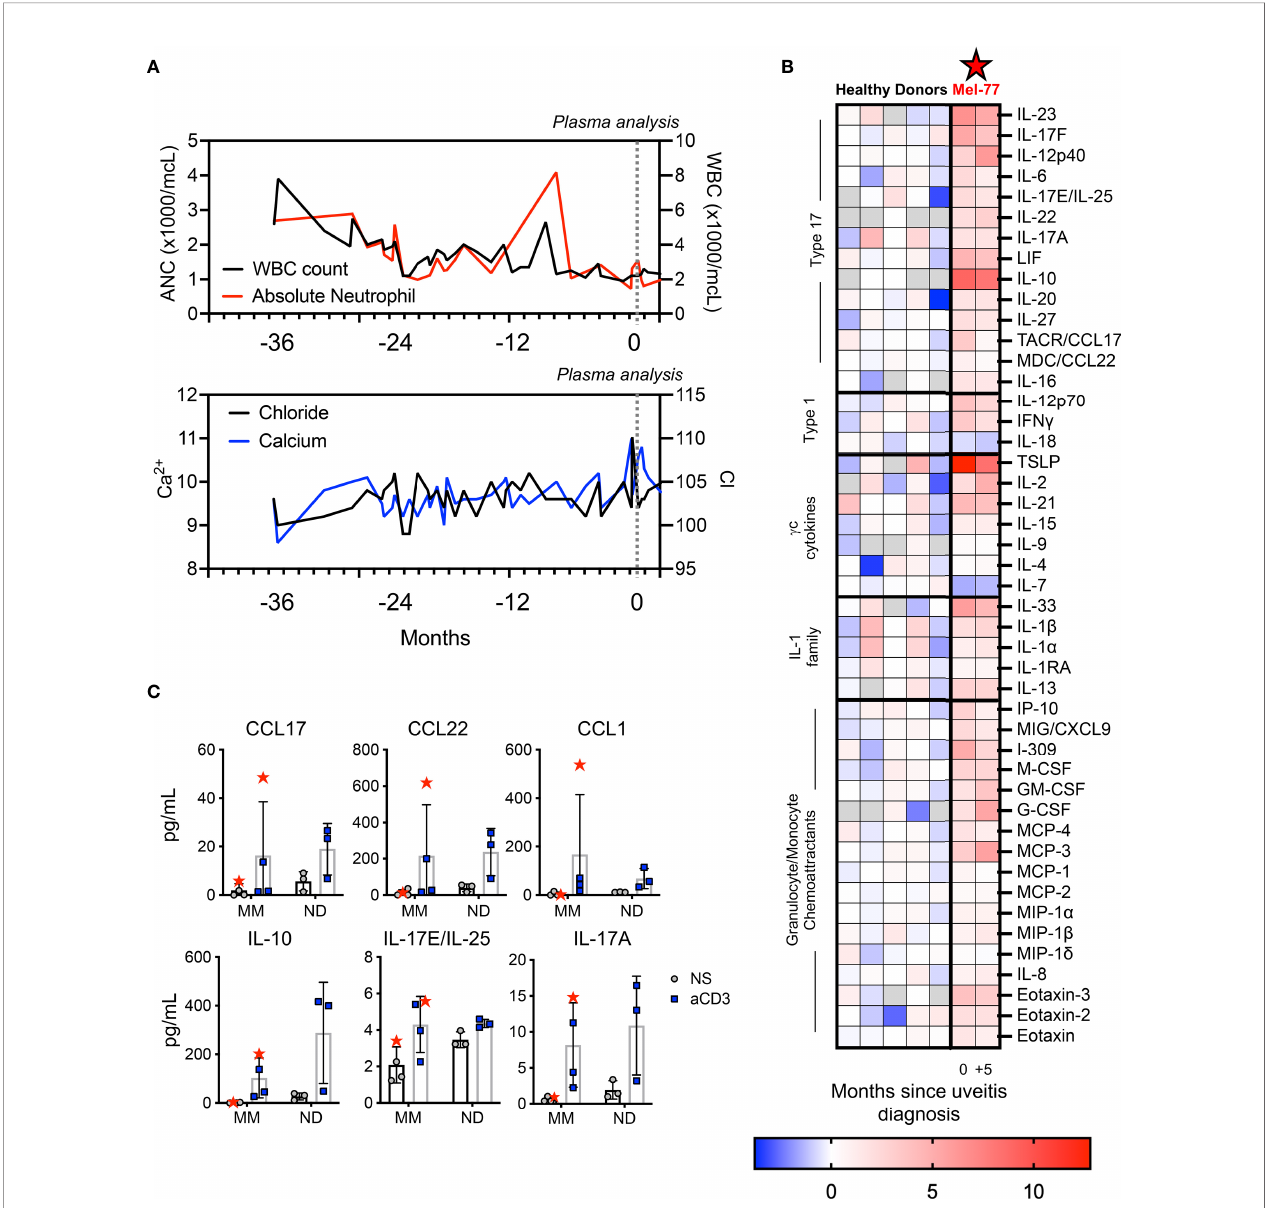
FIGURE 3 | Pronounced peripheral in fl ammation coincided with toxicities in the patient. (A) Lab values over three years of melanoma treatment, with T0 representing the time of inpatient care for renal failure. (B) Heat map displays ± log2 fold change of the plasma cytokines of the patient relative to the median value for fi ve healthy donor plasma samples. The fi ve healthy donors are also displayed on the left. The two time points for the patient, 0 and +5, are indicated to correspond with (A) and indicate 5-month follow-up. Gray boxes indicate the value was below the limit of detection for the assay. (C) PBMCs were stimulated overnight with 1 ug/ml plate bound a CD3 agonist. Samples from three other pre-treatment metastatic melanoma patients (MM) and three healthy donors (ND) are shown as controls. The patient studied here is indicated as Mel-77 (red